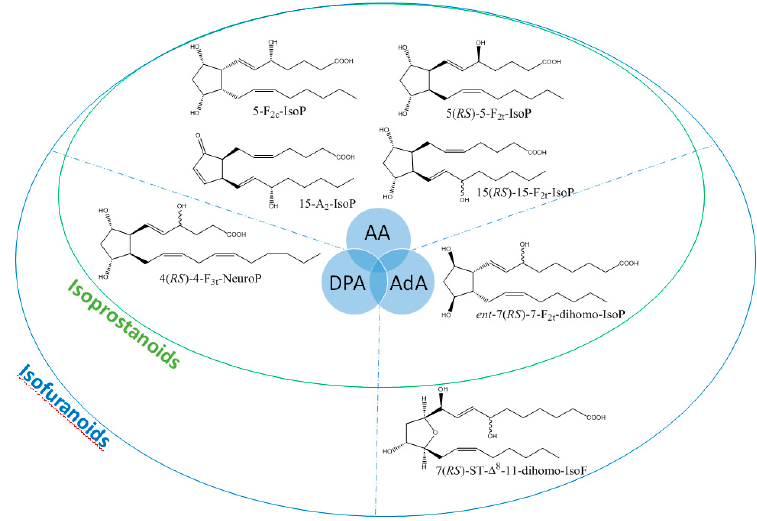
Figure 2. Structure of some isoprostanoids isomers derived from n-6 PUFAs: AA (arachidonic acid), DPA n-6 (docosapentaenoic acid) and AdA (adrenic acid).